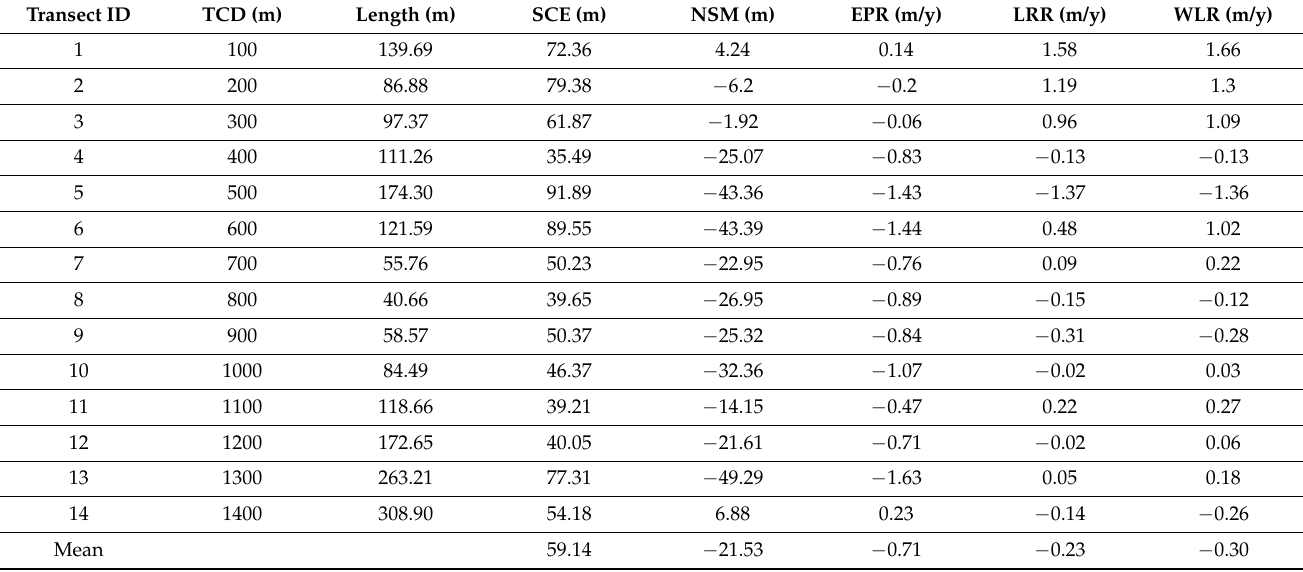
Table 3. Shoreline change statistics at Teluk Nipah Beach indicating accretion/erosion at each transect.